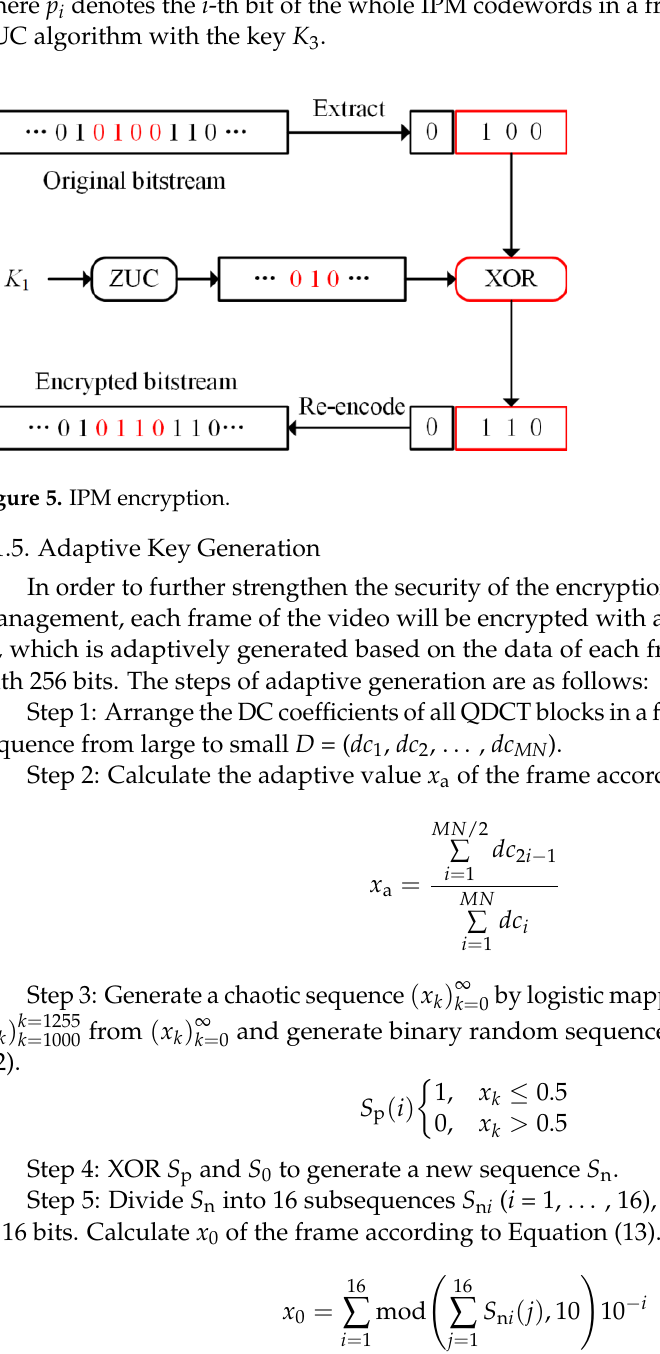
Figure 5. The IPM of the first row or column will not be encrypted because it may cause decoding errors. The encryption method is as follows: